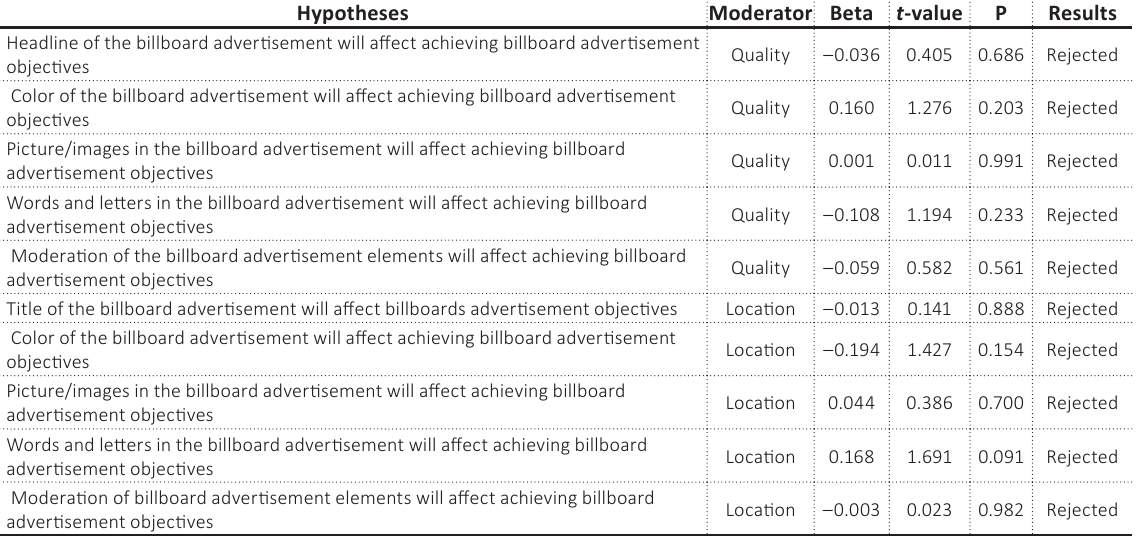
Table 5. Research hypotheses results (indirect